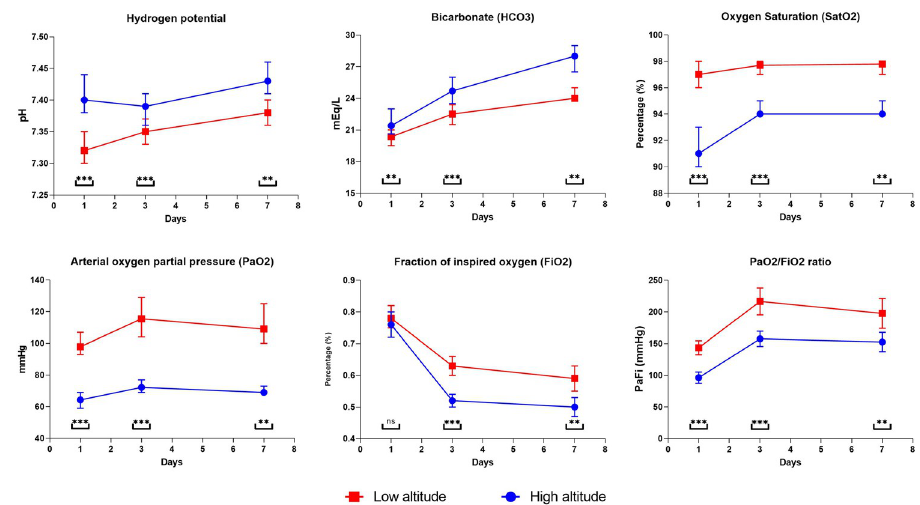
Fig 2. Statistical differences among respiratory and blood serum parameters among COVID-19 patients living at two different elevations. All comparisons were calculated using a U Mann-Whitney. Except for bicarbonate on seventh day � = < 0.05; �� = < 0.01; ��� = < 0.001; ns = non-significant.